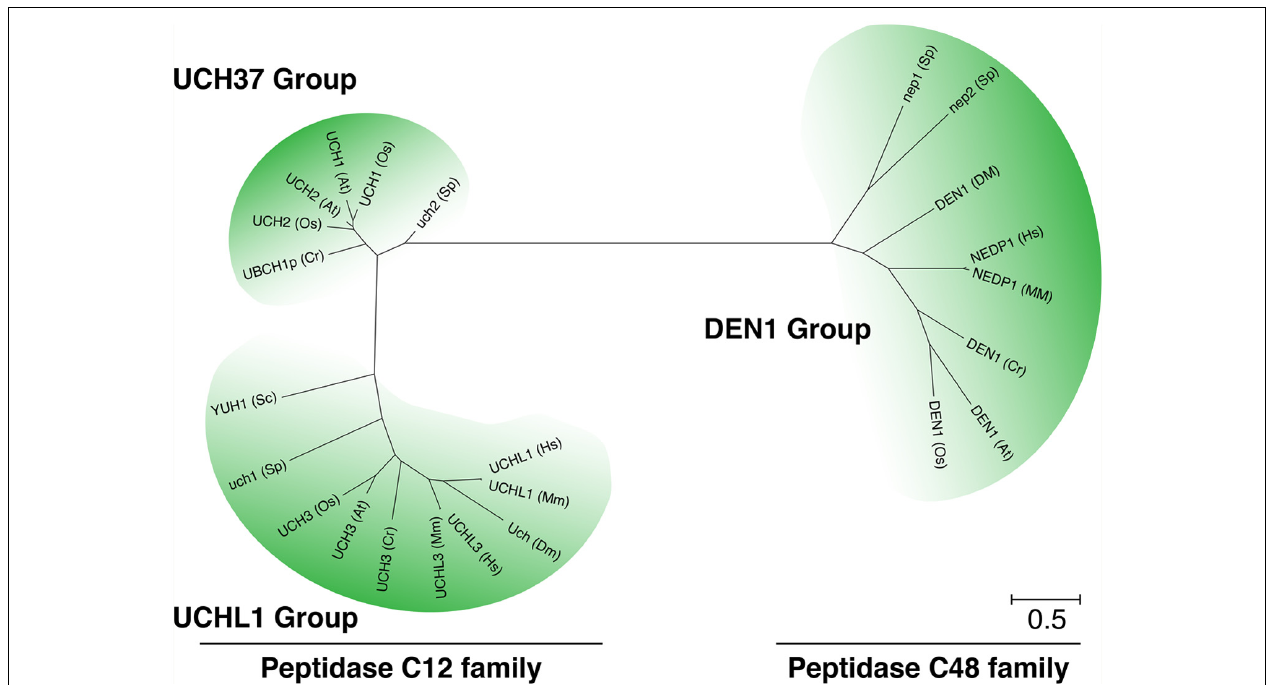
CLUSTALW algorithm at the EMBL-EBI website (http://www.ebi.ac.uk/Tools/ msa/clustalw2/).The tree with the highest log likelihood ( − 5916.8263) is shown. Initial tree(s) for the heuristic search were obtained automatically by applying the Maximum Parsimony method.The tree is drawn to scale, with branch lengths measured in the number of substitutions per site.The analysis involved 24 protein sequences. All positions containing gaps and missing data were eliminated.There were a total of 145 positions in the final dataset. Evolutionary analyses were conducted in MEGA5 (Tamura etal.,